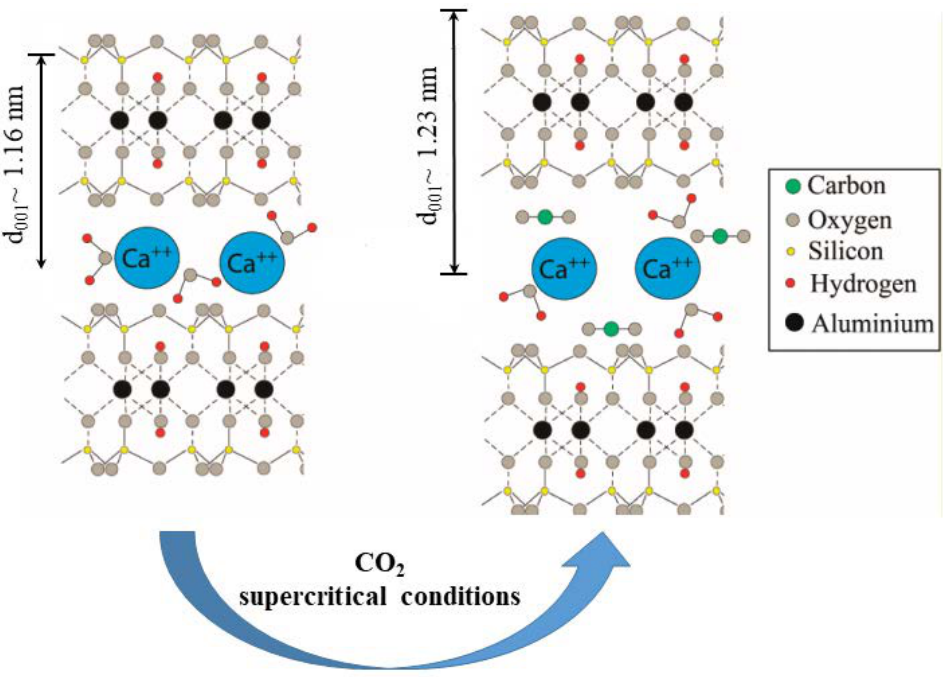
Figure 3. CO 2 adsorption on the interlayer spacing of a smectite under supercritical conditions.